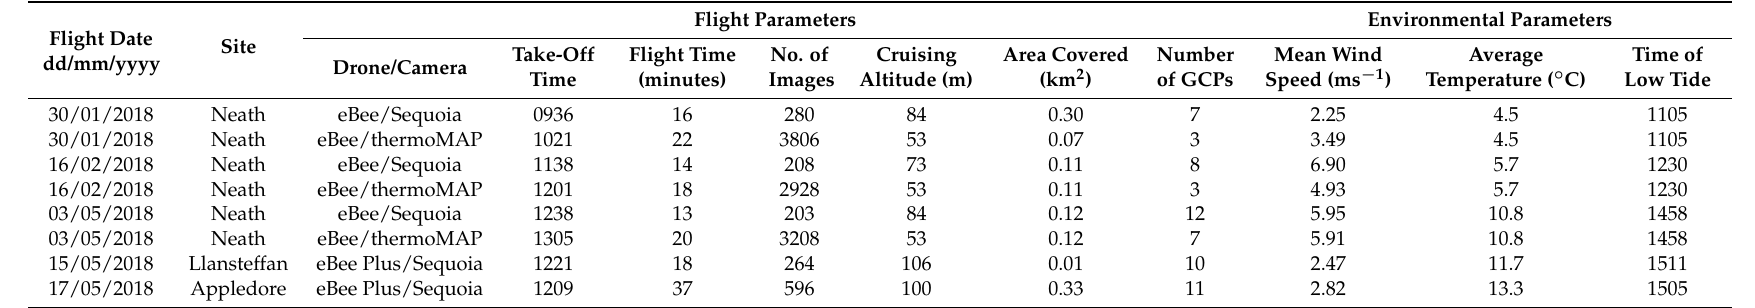
Table 1. Flight and environmental parameters for all conducted flights. Mean wind speed is that recorded by the drone in flight; average temperature from the closest weather station to site and times of low tide taken from Port Talbot for the Neath flights, Ferryside for the flight at Llansteffan and Appledore for the Appledore flight. All tidal data taken from